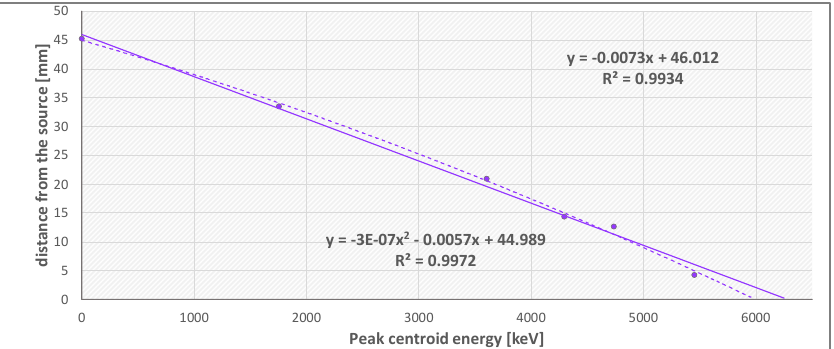
Figure 10. Measurements of the Am-241 α peak centroid as a function of the distance between the source and the detector and the linear and a square fit used to interpolate the distance